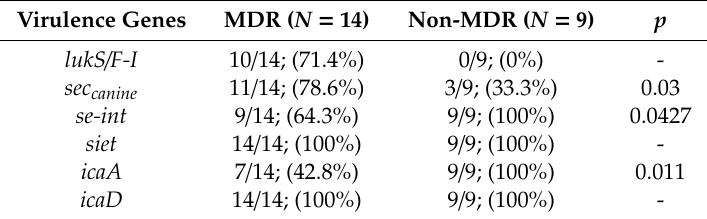
Table 2. Dissemination of virulence genes among MDR and non-MDR